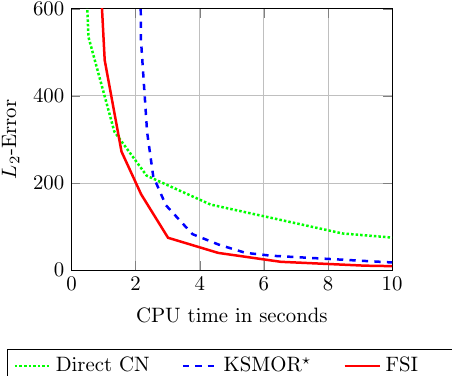
Figure 12. Results of the GES experiment for temperature probe B1 (3rd from the top): comparison of the L 2 -error (along the temporal axis) and the corresponding CPU time between FSI, direct CN and KSMOR (cid:63) with q = 2, s = 10. The parameters are fixed to t F = 21 grid points). The reference solution is computed with EE. The FSI scheme is the most efficient solver.